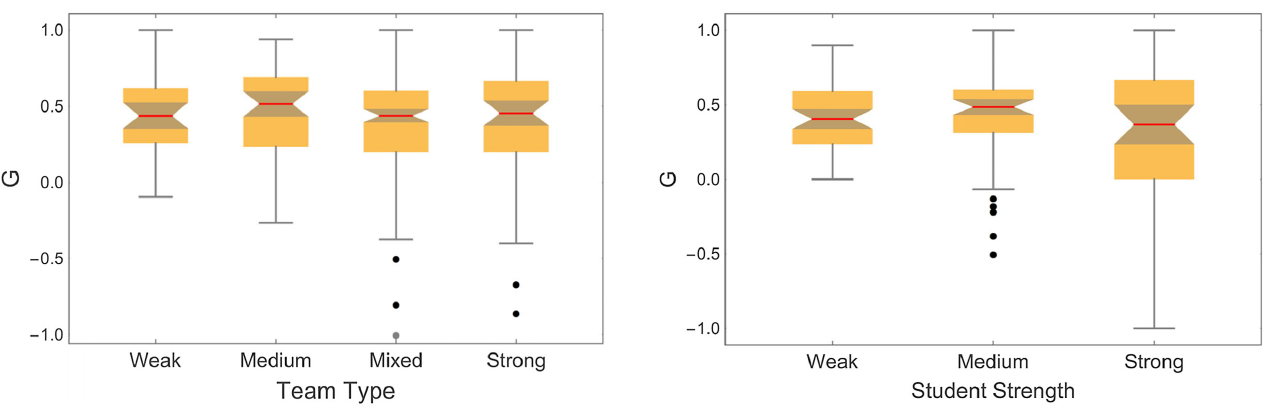
FIG. 3. Box plot of G for different types of teams. FIG. 4. Box plot of G for different student strengths in mixed teams.